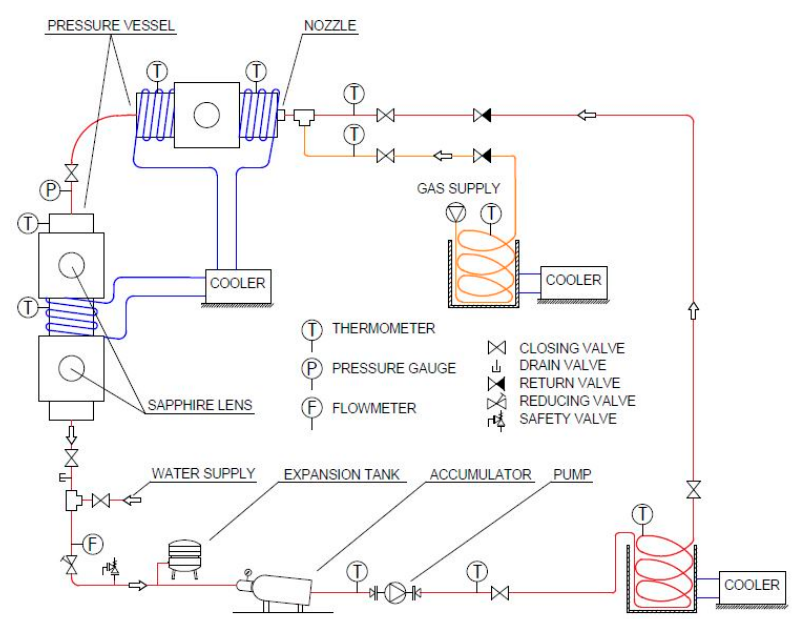
Figure 1. Scheme of experimental device. The total pressure in the high-pressure circuit was recorded by an absolute pressure sensor located between the upper and lower high-pressure vessels. The pump operates as a circulator, and the pressure behind it is determined by the pressure resistance of the nozzle and the reduction valve. For us, the flow rate was decisive, which we regulated by the pump speed using a frequency